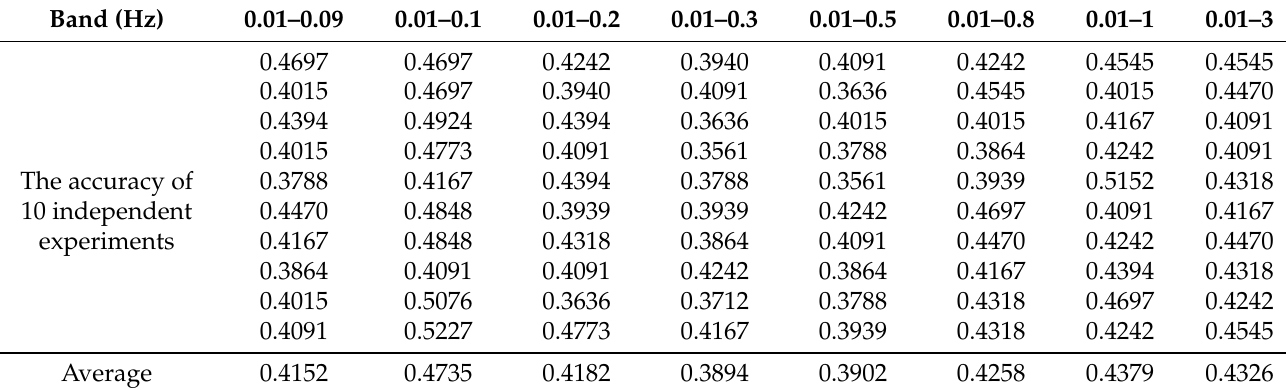
Table 1. Comparison results of FIR band-pass filter with different upper cut-off